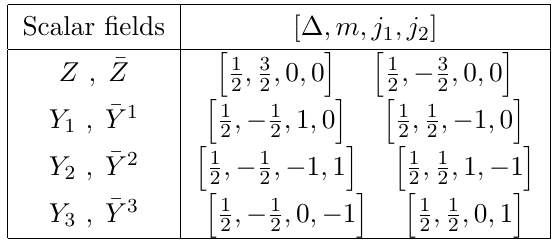
Table 3. Quantum number assignments to scalar matter fields of the ABJ(M) theory defined in eq. (B.16).